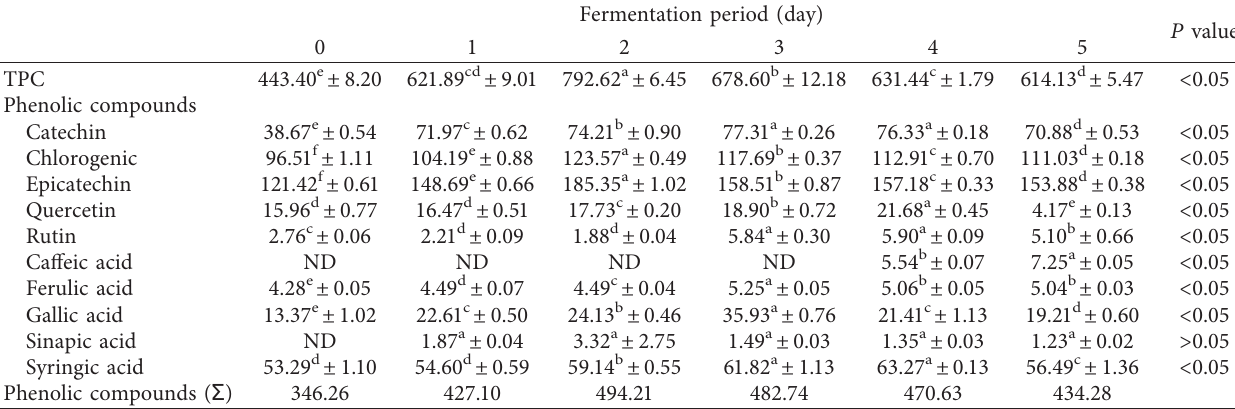
Table 2: Changes in the total phenolic content (TPC, expressed in mg GAE/100g) and phenolic compounds (expressed in mg/100g) of